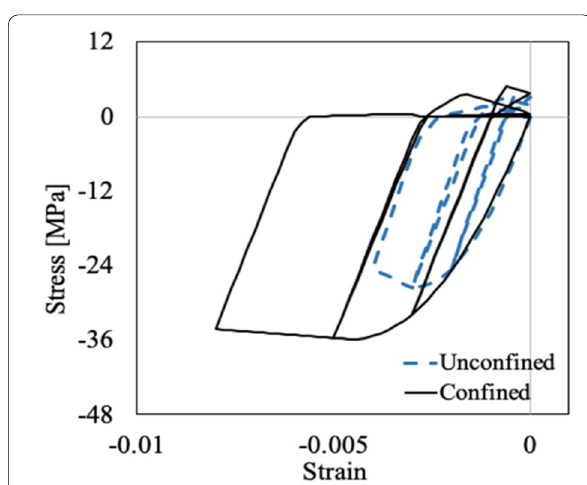
Fig. 3 Typical response of cover (unconfined) and core (confined)